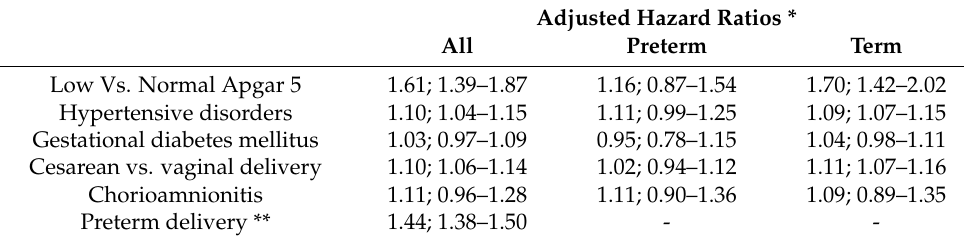
Table 3. Total neurological-related hospitalizations and low vs. normal Apgar scores *.